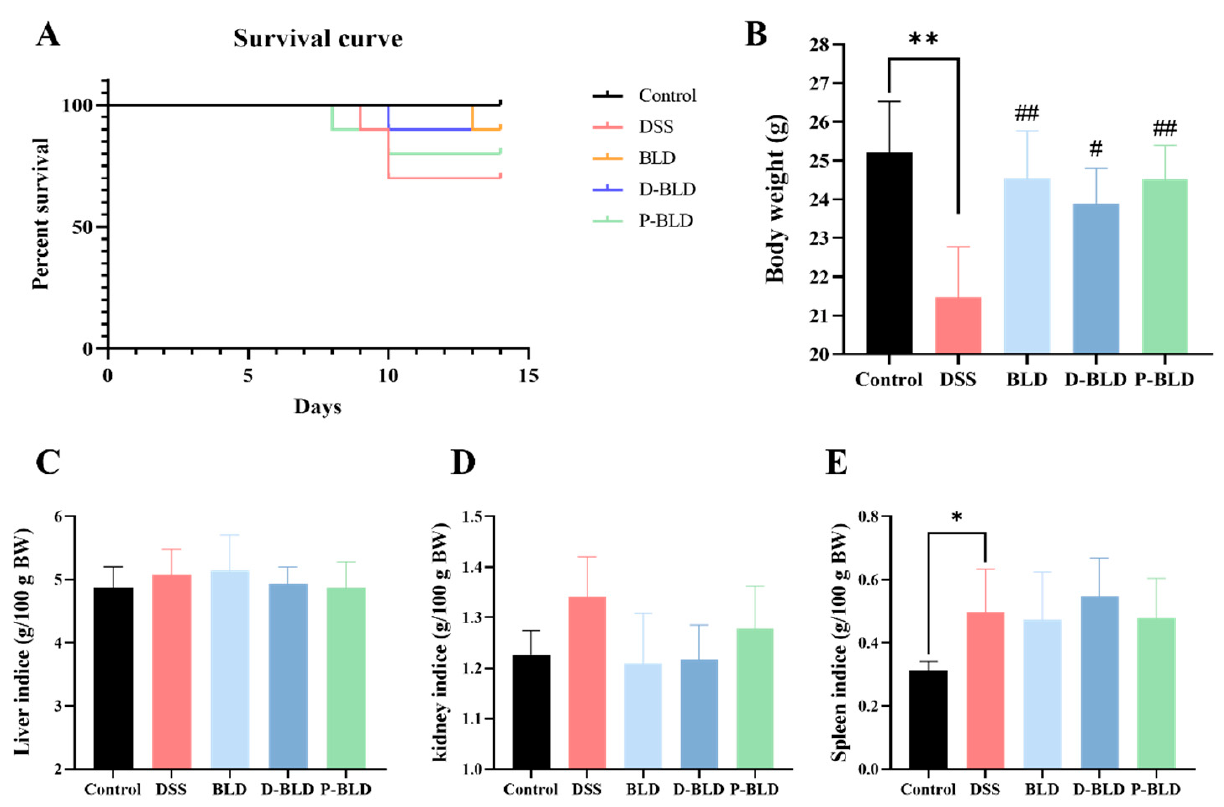
Figure 2. Effect of S. boulardii and its postbiotics on the survival curve, body weight, and organ index of mice with DSS-induced colitis. ( A ) Survival curve. ( B ) Body weight. ( C ) Liver index. ( D ) Kidney index. ( E ) Spleen index. Note: Data are expressed as mean ± SD. Comparison of significant differ- ences between groups is indicated, where * p < 0.05, ** p < 0.01 compared with Control group; # p < 0.05, ## p < 0.01 compared with DSS group.